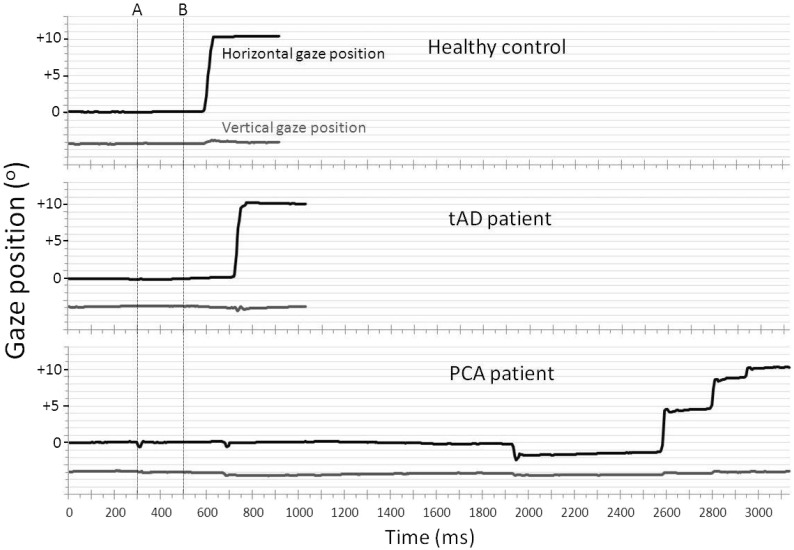
Representative traces from the saccade task for a healthy control, a patient with typical Alzheimer’s disease and a PCA patient in an ‘overlap’ trial. The upper plot (grey line) for each participant shows gaze position in the y (vertical) axis, the lower plot (black line) shows gaze position in the x (horizontal) axis. Gridlines show displacement of 1° of visual angle. Positive values of gaze position indicate rightward gaze. A central fixation point was present from the start of the trial until time point B (500 ms). The target appeared at 10° horizontally to the right of the central fixation point at time point A (300 ms) and remained present until the end of the trial. The healthy control and patients with typical Alzheimer’s disease make a single saccade towards the target. The PCA patient takes a long time to initiate their first saccade (in the incorrect direction), followed by a number of small saccades to reach the target location. tAD = typical Alzheimer’s disease.